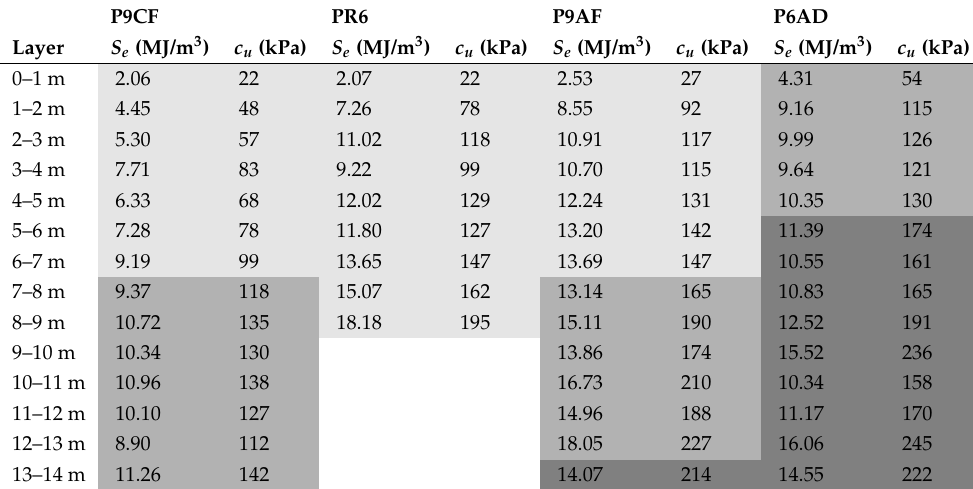
Table 2. c u Estimation. Color code: Silty Clay (light gray) Clayey Silt (medium gray) Silt (dark gray). P9CF PR6 P9AF